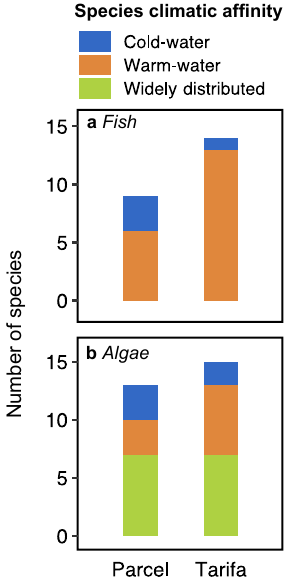
Figure 3. Number of fish ( a ) and algae ( b ) species by climatic a ffi nity in Parcel and